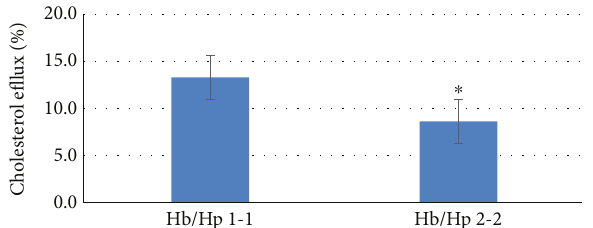
Figure 4: The e ff ect of Hp genotypes on the cholesterol e ffl ux of oxidized HDL. Hb-Hp1-1 or Hb-Hp 2-2 complexes were incubated Figure 3: Hydroxyurea addition to HDL, Hb, and H O inhibits Hb 2 2 with the same HDL preparation in the presence of H cross-link formation. HDL (obtained from the plasma of healthy molar excess) for 1 hour. After incubation, the samples were volunteers), Hb, and H O (1 :10 ratio) were incubated with 2 2 added to macrophages and the e ffl ux of ( 3 H) cholesterol from di ff erent concentrations of hydroxyurea for 1 hour. The samples macrophages was measured ( ∗ indicates the p value < 0.001 (t-test) were loaded on SDS-PAGE gel, transferred to a PVDF membrane, comparing Hb/Hp 1-1 versus Hb/Hp and stained with anti-Hb antibody. The sample order is (1) HDL, (2) HDL+ Hb+H O , (3) HDL+Hb, (4) Hb, (5) Hb+H O , (6) 2 2 2 2 HDL+Hb +H O +hydroxyurea (400nM), (7) HDL+Hb +H O 2 2 2 2 +hydroxyurea (200nM), (8) HDL+Hb +H O +hydroxyurea 2 2 (100nM), and (9) HDL+Hb +H O +hydroxyurea (10 nM). 2 2